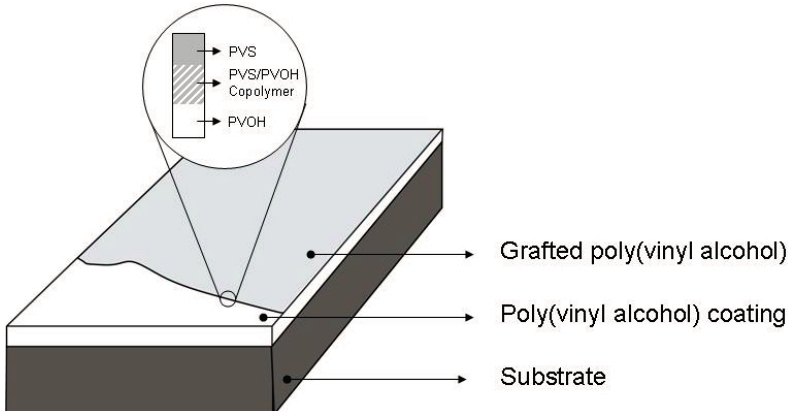
Figure 3. Schematic representation of a PVOH-coated substrate grafted with stearic acid and the grafting assembly, adapted from